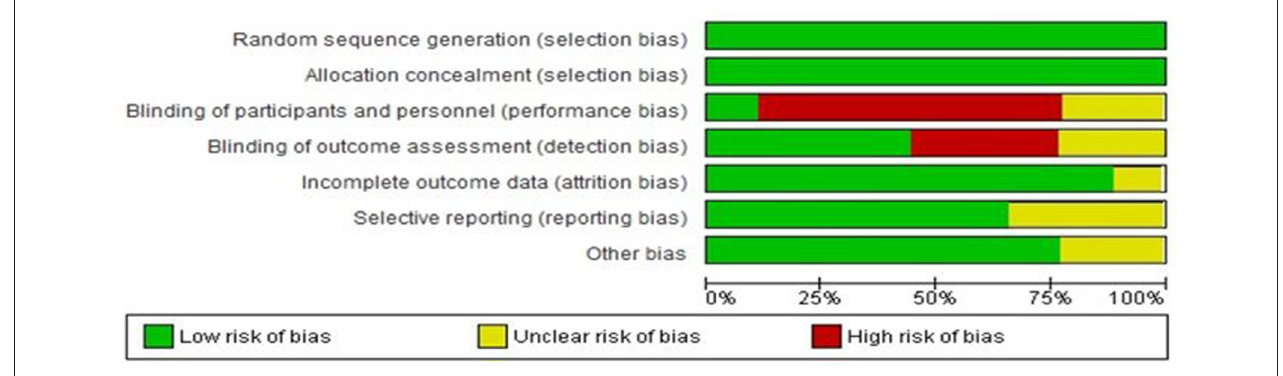
FIGURE 1 | Risk of bias graph: review authors’ judgments about each risk of bias item presented as percentages across all included